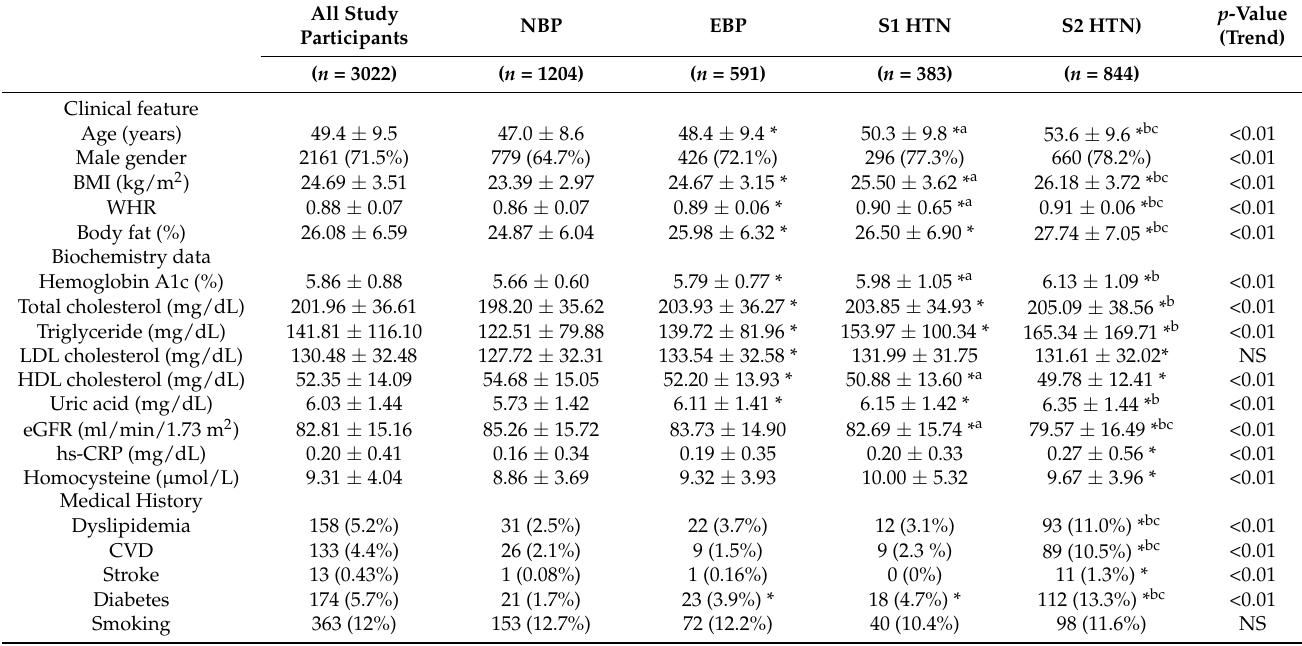
Table 1. Clinical and baseline characteristics of patients with normal blood pressure (NBP), elevated blood pressure (EBP), and stage 1 (S1) and stage 2 (S2) hypertension